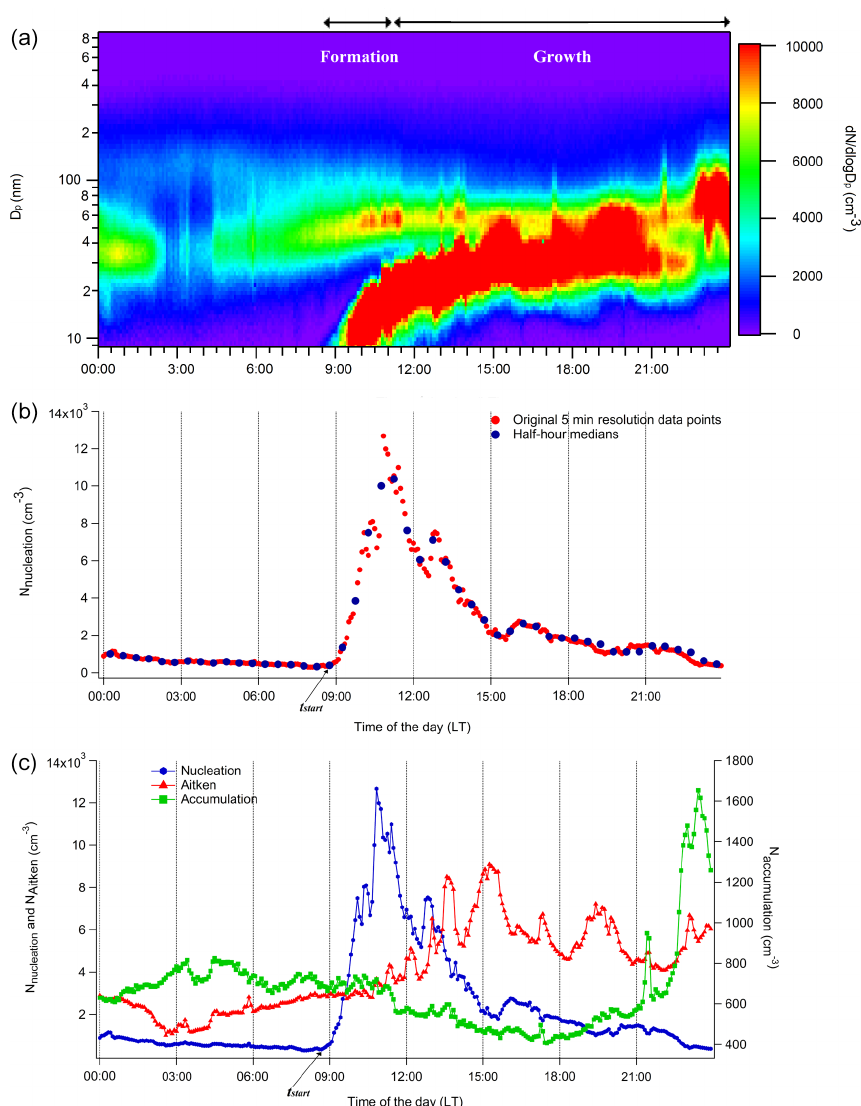
Figure 1. A “representative” new particle formation event captured at Finokalia on 29 August 2012. (a) Diurnal evolution of the aerosol size distribution, (b) temporal evolution between 5min resolution original points (red dots) and calculated half-hour median concentrations of particles in size range of 9–25nm (blue dots), and (c) diurnal evolution of nucleation (blue line), Aitken (red line), and accumulation mode particle number concentration (green line),